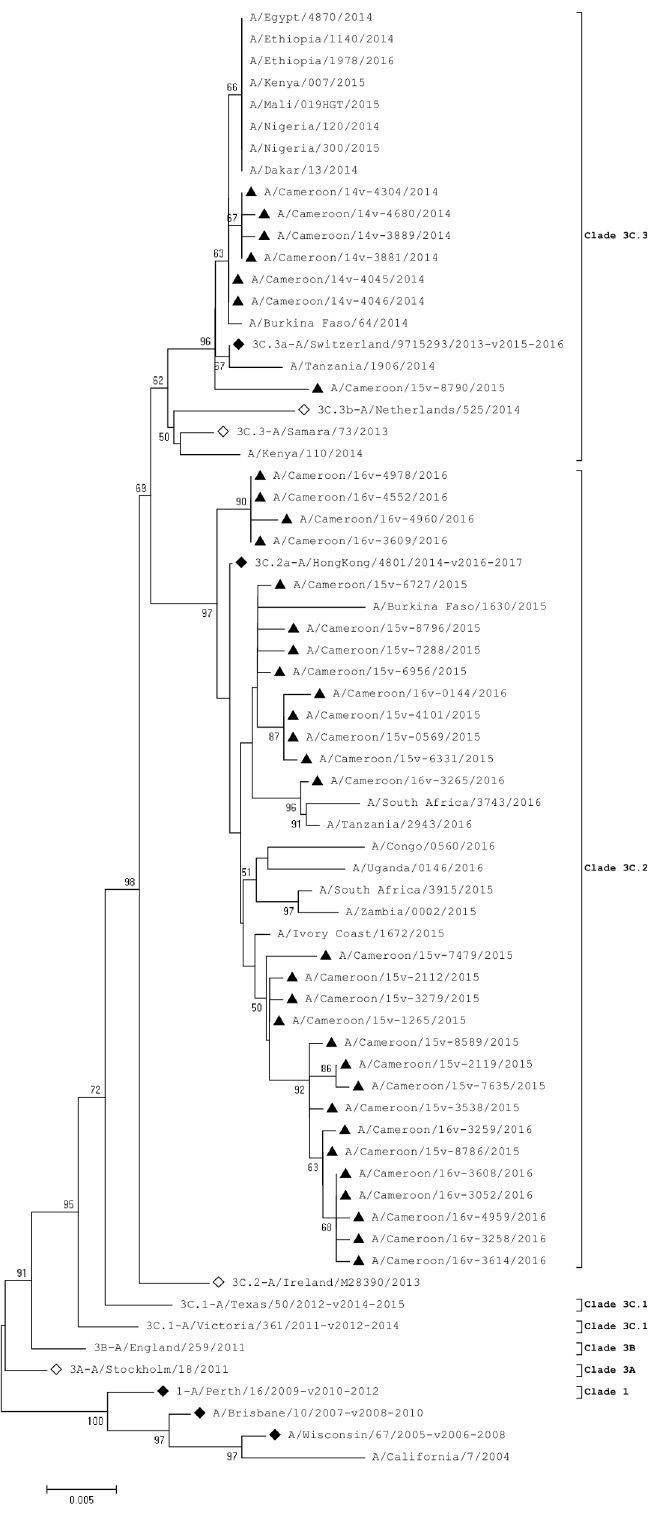
Fig 1. Phylogenetic analysis of HA nucleotide sequences of influenza A(H3N2). ^ represent reference strains of known clades, ♦ representthe northern hemisphere vaccine strains recommended by WHO and ▲ representCameroonian